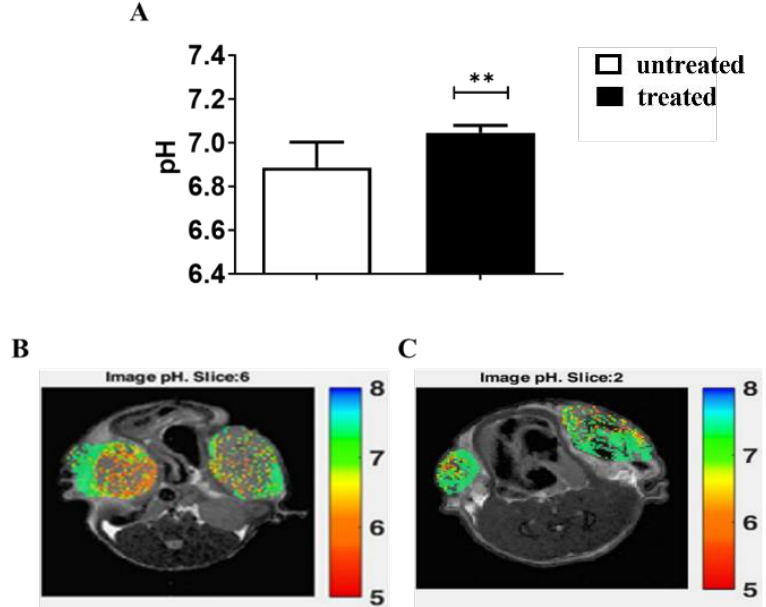
Figure 4. MRI-CEST extracellular tumor pH values for PC3 subcutaneous tumor murine model after 3 h of Esomeprazole administration (dose: 2.5 mg/kg b.w.) by gavage in treated (N = 4) and untreated (N = 5) groups ( A ). The statistical differences resulted from unpaired Student’s t -test (** p value < 0.01). pH maps showing the pH distribution across tumor regions in a representative untreated mouse ( B ), average tumor pH = 6.82) and in a treated mouse ( C ), average tumor pH =